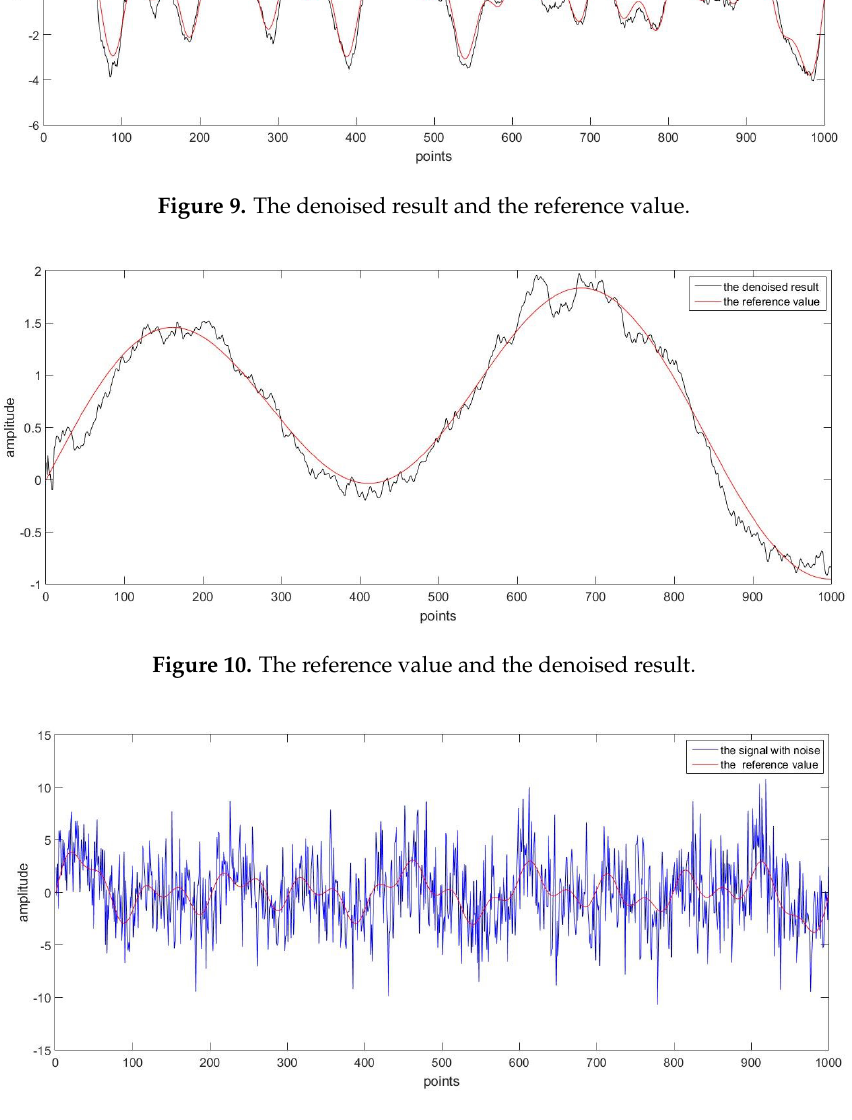
Figure 11. The signal with noise and the reference